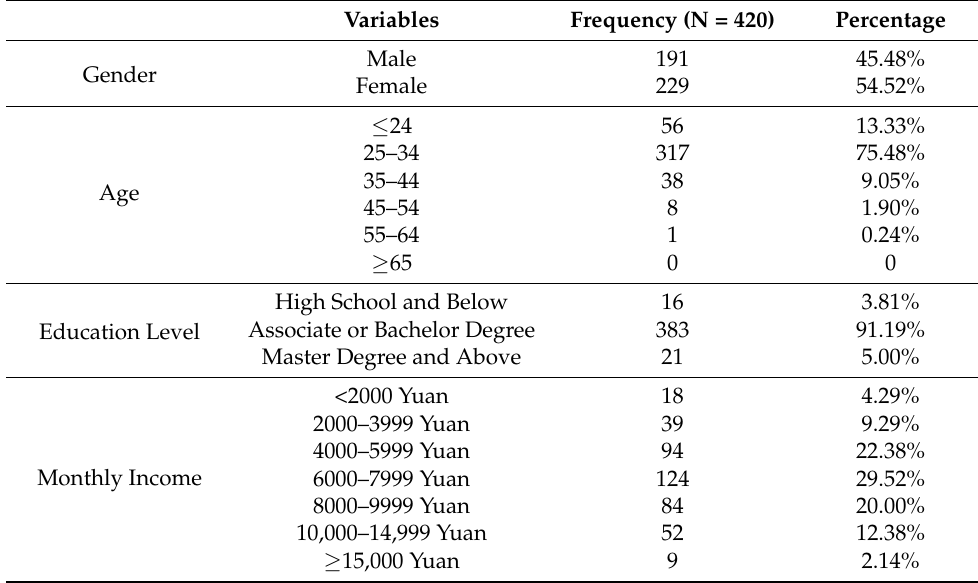
Table 3. Socio-demographics and economic characteristics of